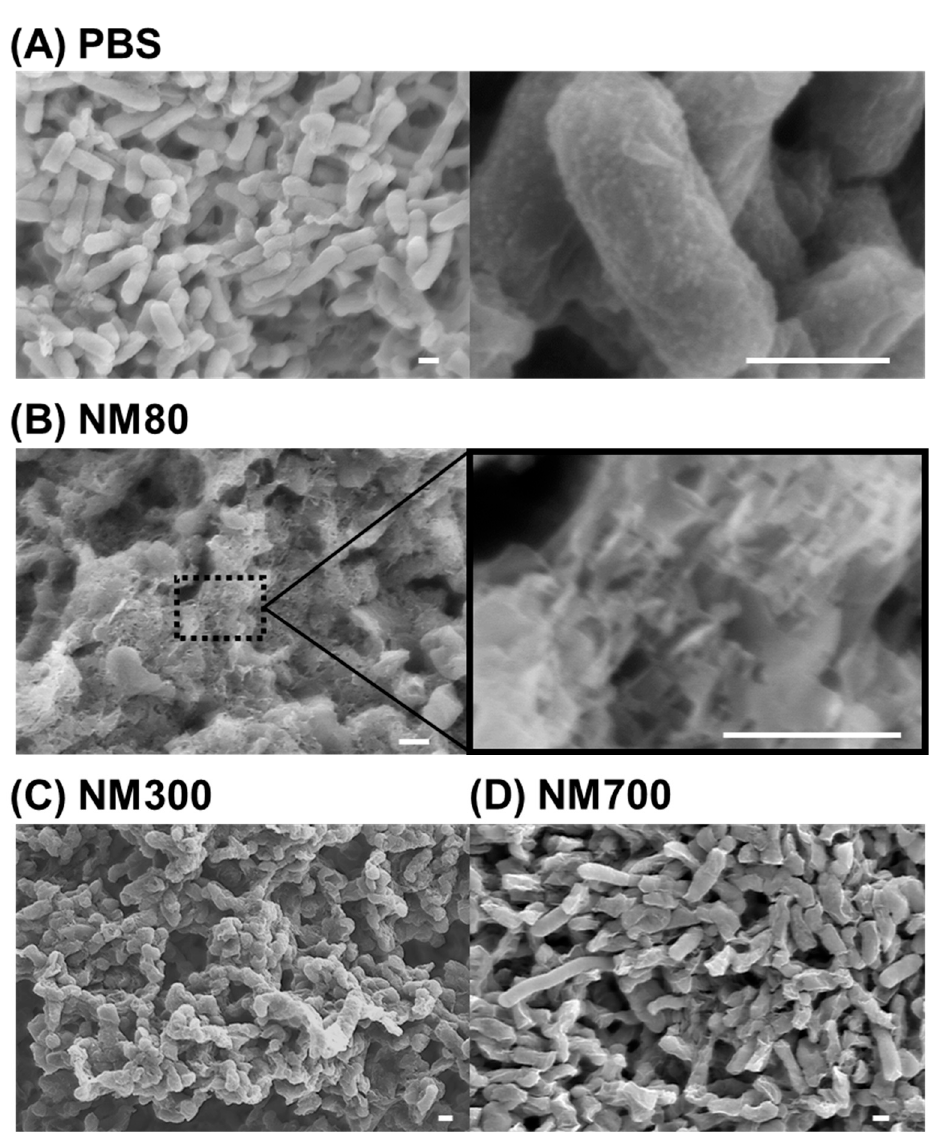
Figure 5. SEM images of E. coli treated by NM80, NM300, and NM700. ( A ) PBS-treated E. coli as a control. Scale bar indicates 2 µm (×10,000). Right image is a magnified image. Scale bar indicates 500 nm (×80,000). ( B ) NM80-treated E. coli . Scale bar indicates 1 µm (×15,000). Right image is a magnified image. Scale bar indicates 500 nm (×100,000). ( C ) NM300-treated E. coli . Scale bar indicates 2 µm (×7000). ( D ) NM700-treated E. coli . Scale bar indicates 2 µm (×9000). All samples were treated with